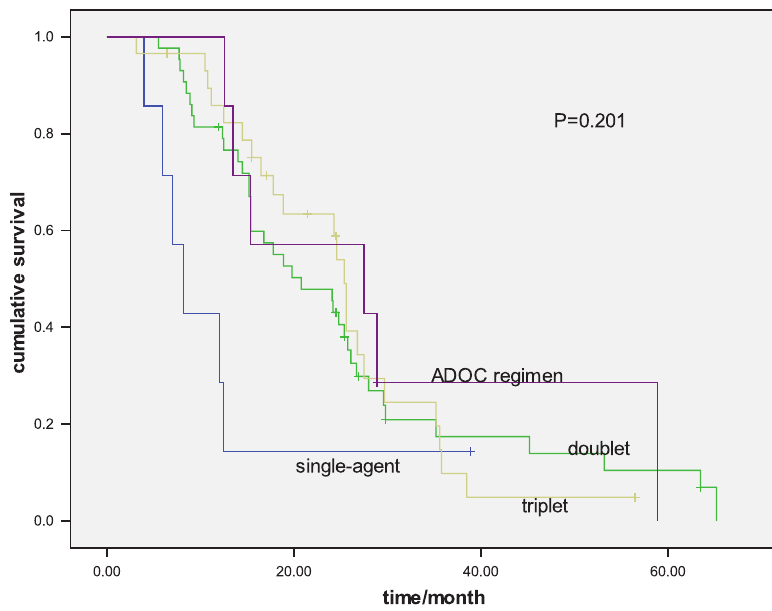
Figure 2 - Kaplan–Meier curves comparing OS in patients treated with various first-line chemotherapy regimens.